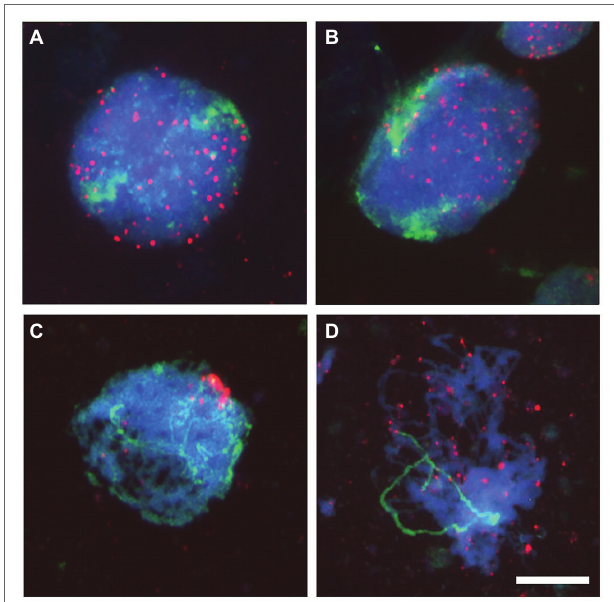
FIGURE 1 | Telomeres dynamic at the onset of meiosis in a wheat line carrying a pair of homologous chromosomes from the wild barley Hordeum chilense . Telomeres (red) and H. chilense chromosomes (green) were detected in fluorescence in situ hybridization (FISH) experiments in wheat meiocytes. Total genomic DNA was counterstained with DAPI (blue). (A) Early meiotic nucleus with all telomeres dispersed. Barley chromosomes are occupying different regions within the nucleus. (B) As meiosis progresses, telomeres start associating and physically located in one side of the nucleus. (C) Early meiotic nucleus with the telomeres clustered in a bouquet. Homologous barley chromosomes are intimately interacting and associating in pairs from the telomeric region. (D) Telomeres disperse from the bouquet and homologous chromosomes remained associated in pairs. Bar 10 μ